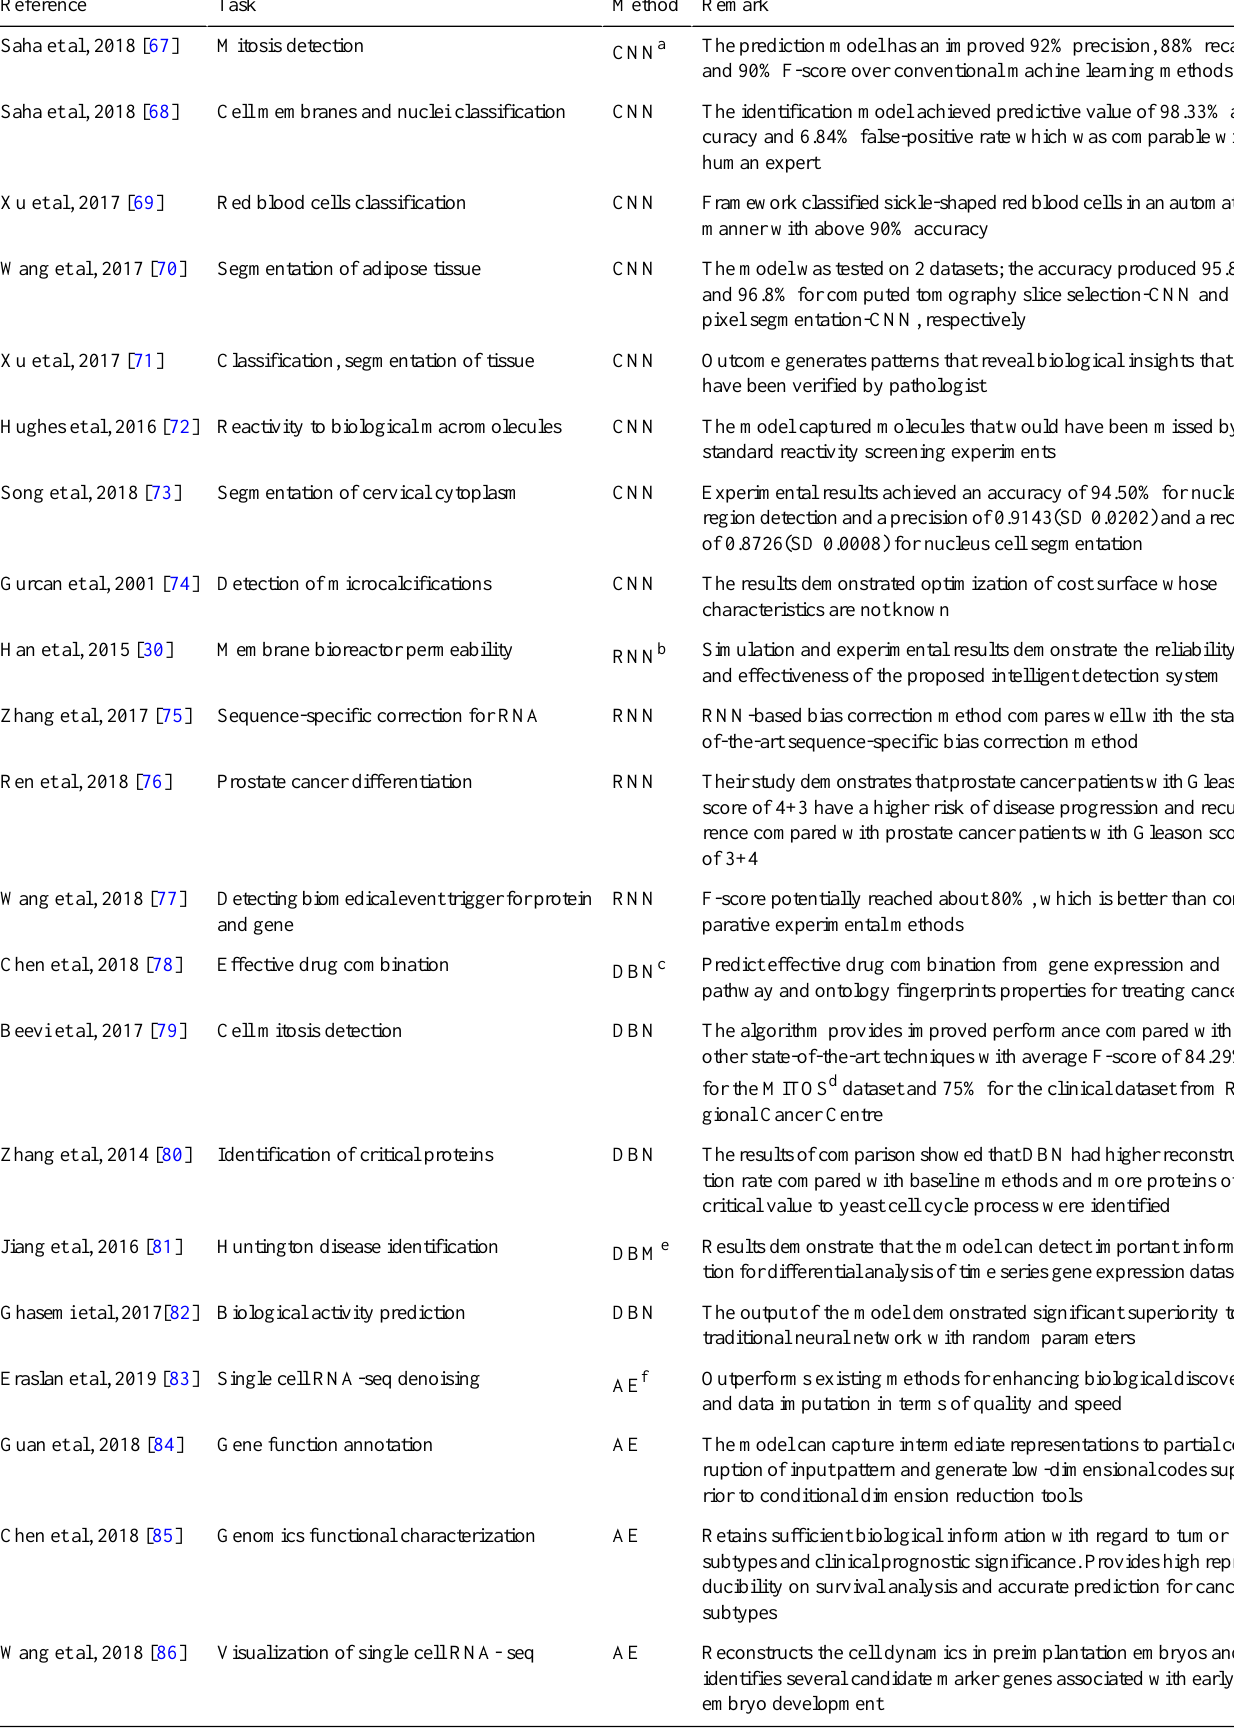
Table 1. Deep learning implementation in biological